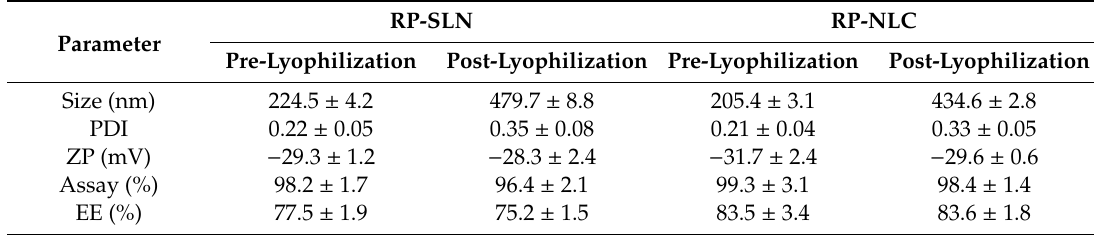
Table 8. E ff ect of lyophilization on physicochemical characteristics of RP-SLN and RP-NLC formulations (mean ± SD, n =